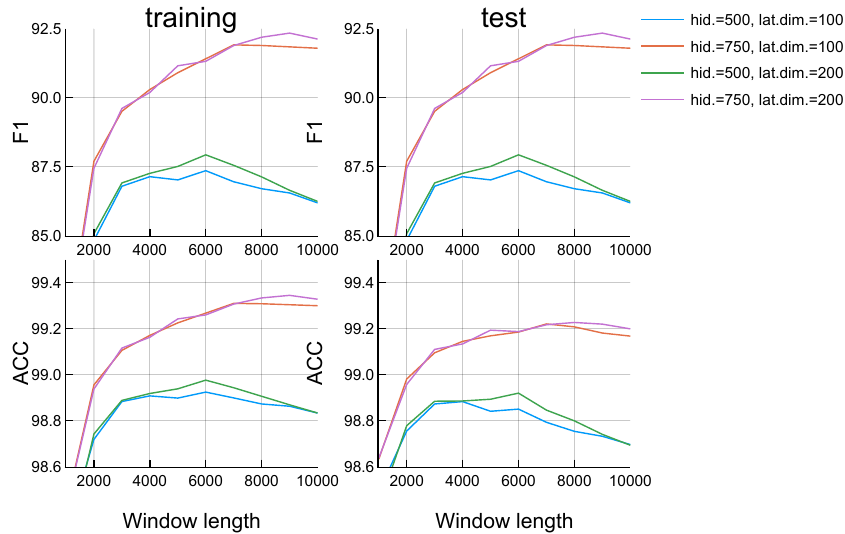
Figure 1. F1 score and accuracy for each configuration of hidden neurons (hid.) and a latent dimension